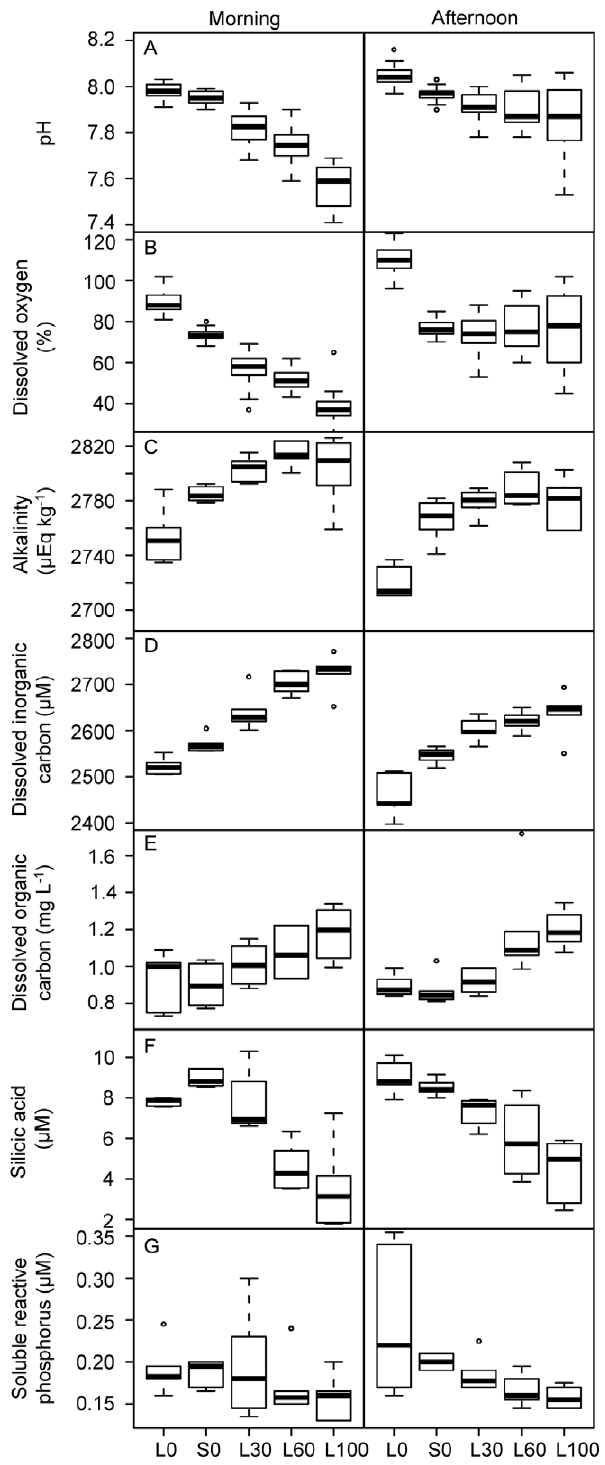
Figure 3. The effects of macroalgae on water chemistry in the laboratory experiment. (A) pH, (B) dissolved oxygen saturation (DO, %), (C) alkalinity (ALK, m Eq/kg), (D) dissolved inorganic carbon (DIC, m M), (E) dissolved organic carbon (DOC, mg L 2 1 ), (F) silicic acid (Si, m M) and (G) soluble reactive phosphorus (SRP, m M) in different experimental treatments, measured in the morning and in the afternoon of days 2 and 6 (see Table 3 and 4 for details). Treatments are light (L) and shading (S) (white and grey boxes, respectively), at increasing concentrations of algal incubated water (0%, 30%, 60% and 100% addition). doi:10.1371/journal.pone.0012685.g003 PLoS ONE |